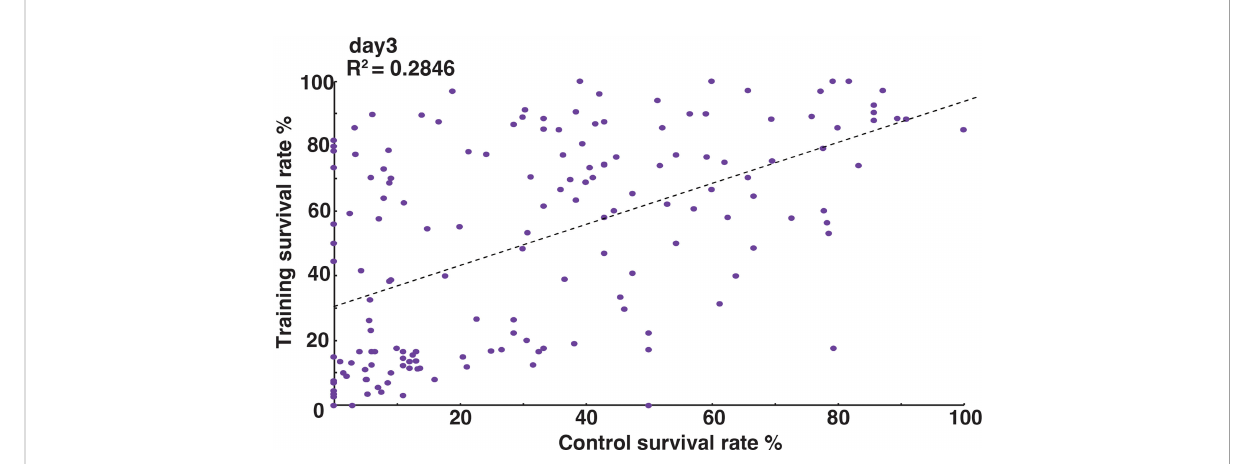
FIGURE 4 Relationship between normal immune responses and training effects. Scatterplot of survival rates on day 3 after Sa challenge under control (x-axis) and training (y-axis) conditions. Each dot represents a single DSPR line. Survival rates under control and training conditions were poorly correlated (R 2 = 0.2846). Scatterplots for other time points are shown in Supplementary Figure